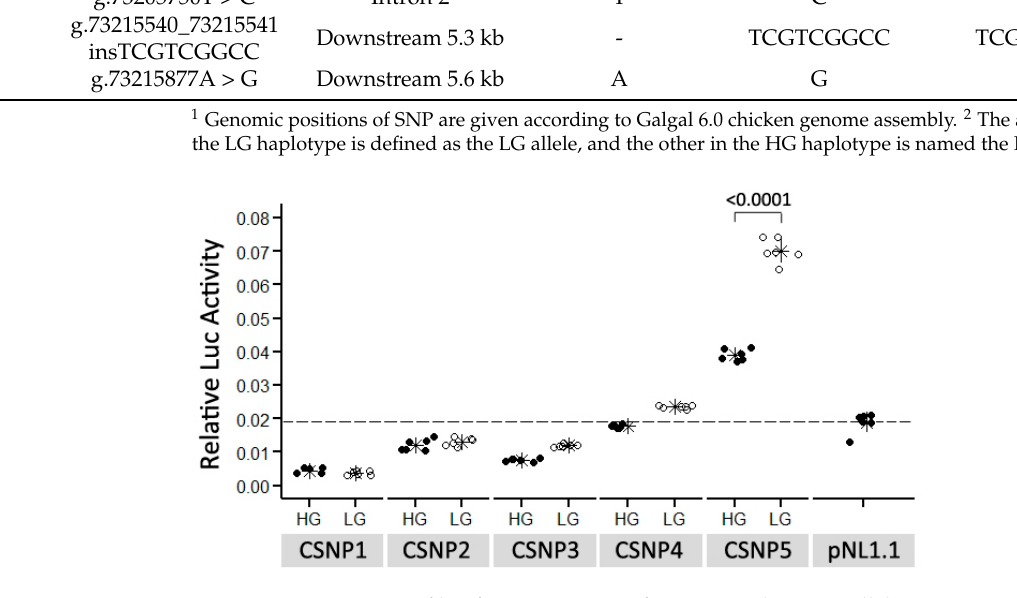
Figure 4. Comparison of luciferase activities of pNLCSNP between alleles. An asterisk represents the mean for each group, and the short lines on both sides of each asterisk represent SD. The number at the top of the pNLCSNP5 column is the p -value of the significance test. The dashed line represents the background signal produced by empty pNL1.1. HG = high-growth allele, LG = low-growth allele.